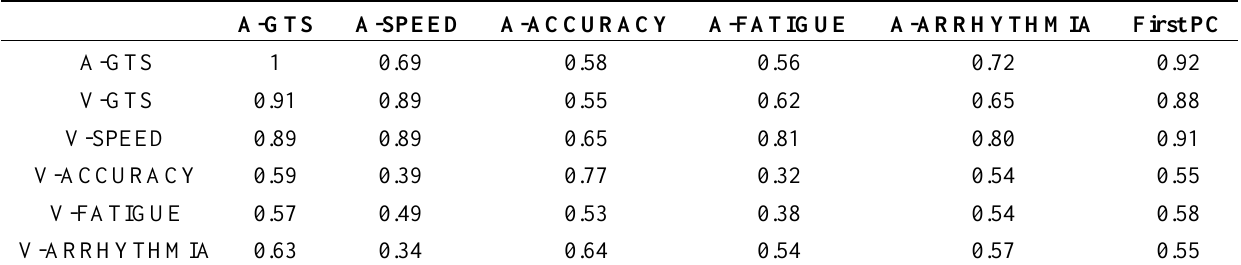
Table 4. Absolute Spearman rank correlations between computed and visual scores.